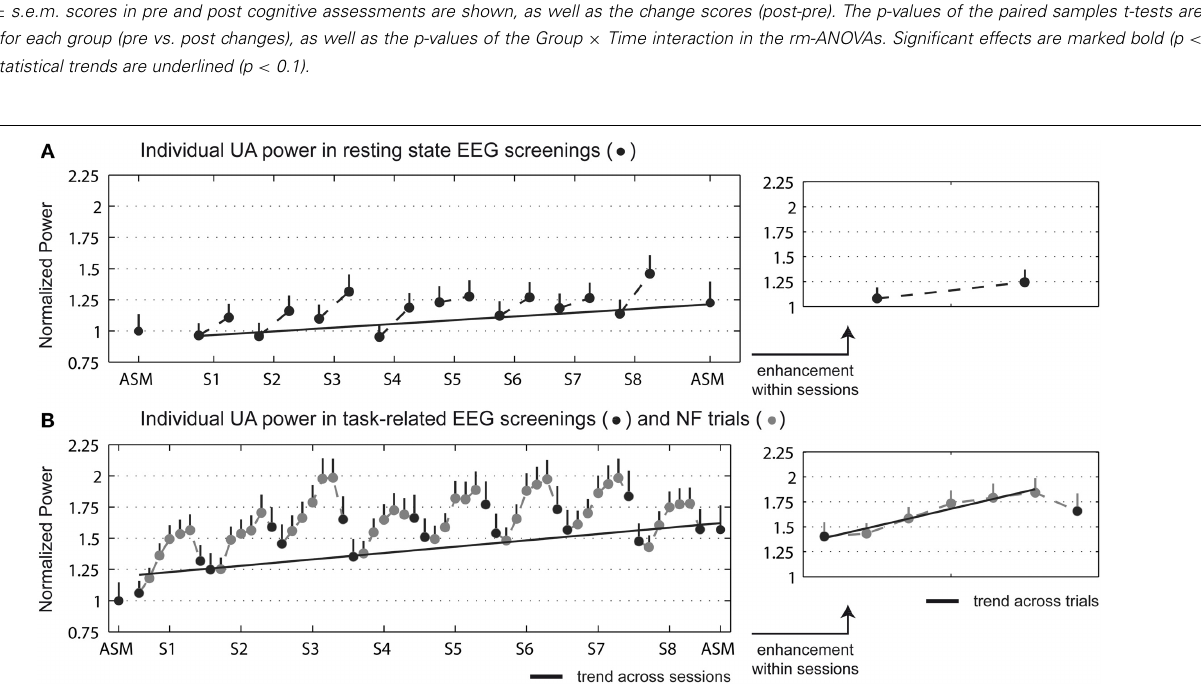
power in the initial screening. Right figures display the power enhancement within sessions, in which in the EEG data of the NF sessions was averaged across sessions. Dark and light gray dots depict EEG screenings and NF trials, respectively, and gray line the relevant trend